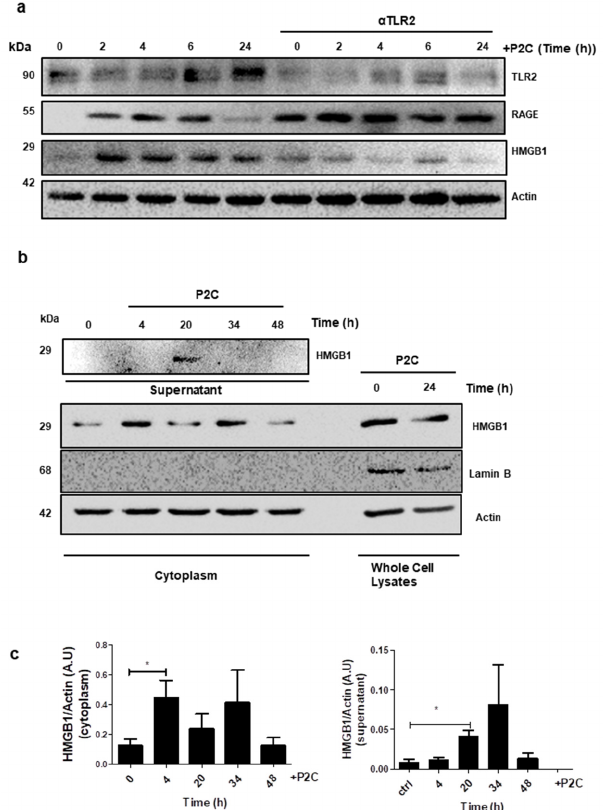
Figure 5. TLR2 stimulation of oesophageal cancer cells induces HMGB1 secretion. SK-GT 4 cells were stimulated with P2C (0.05 µ g/mL) for the indicated times. ( a ) Cellular expression levels of TLR2, RAGE, HMGB1 and actin (loading control) were analysed by Western blot. ( b ) HMGB1 levels in supernatants (upper blot) and in the cytoplasm (lower blots) were analysed by Western blot. Whole-cell lysates were used as a positive control for cytoplasmic isolation; Lamin B—nuclear marker; actin—cytoplasmic marker. ( c ) Densitometry of HMGB1 levels in the cytoplasm and supernatants based on blots from three independent experiments. Values represent the mean ± SEM, * p < 0.05 (unpaired two-tailed Student’s t